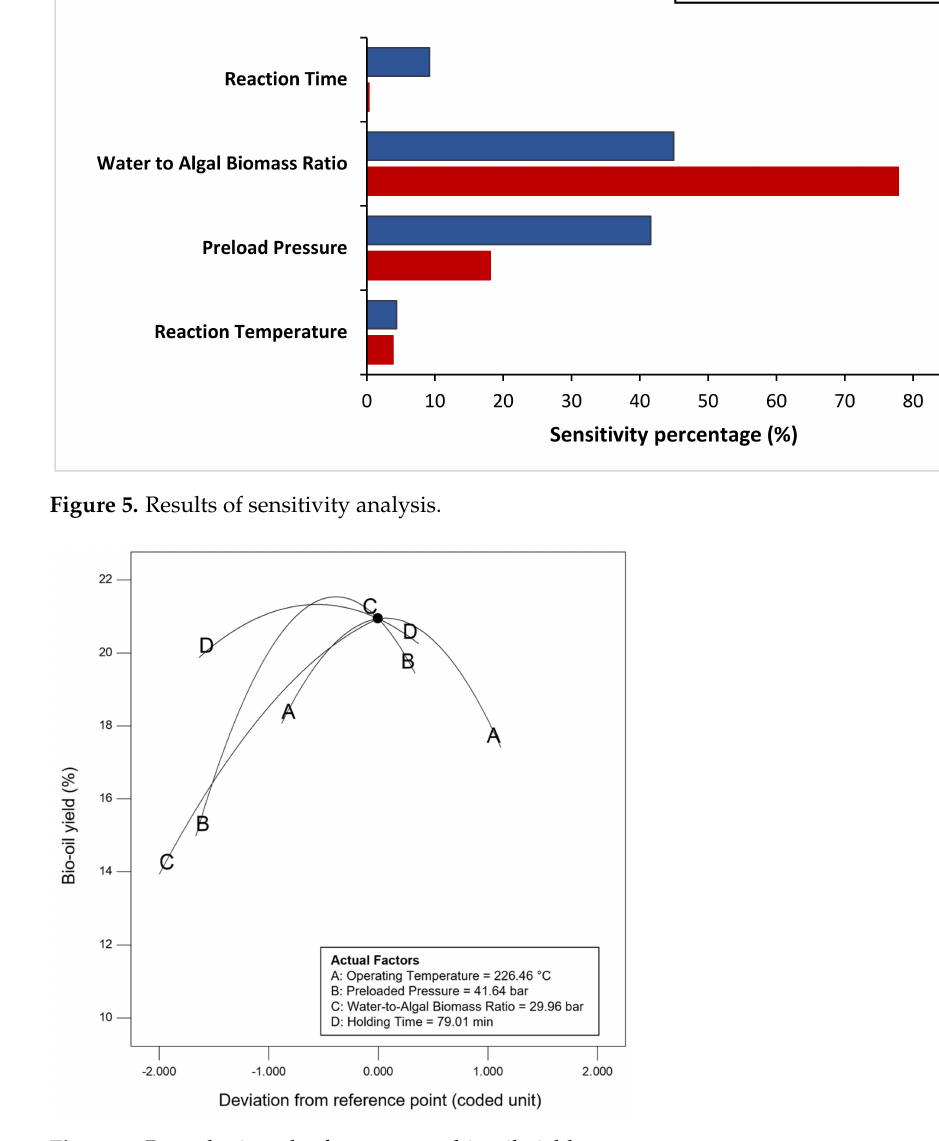
Figure 6. Perturbation plot for response, bio-oil